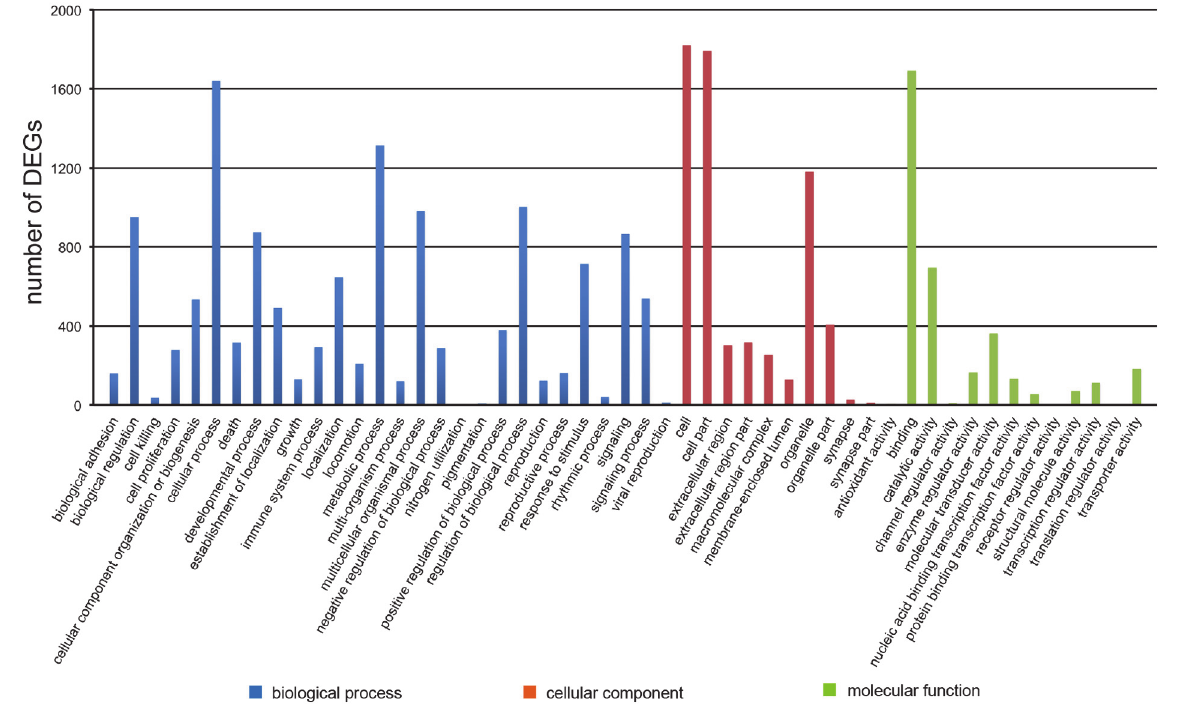
Fig 5. GO functional classification(WEGO) of DEGs. The results were summarized in three main domains: biological process, cellular component and molecular function. In the three main domains, 28, 10 and 13 functional groups were identified respectively.